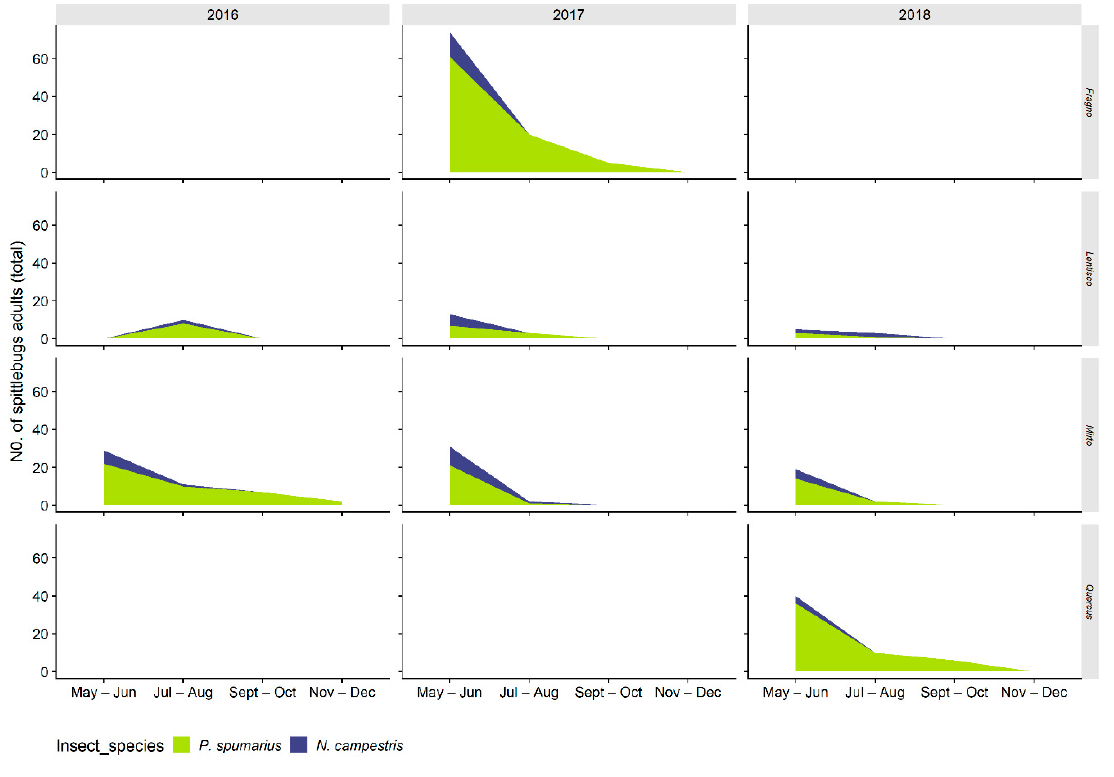
Figure 10. Abundance of spittlebug adults of different species ( Philaenus spumarius , Neophilaenus campestris ) on different wild woody plant species in Apulia olive groves throughout the year.